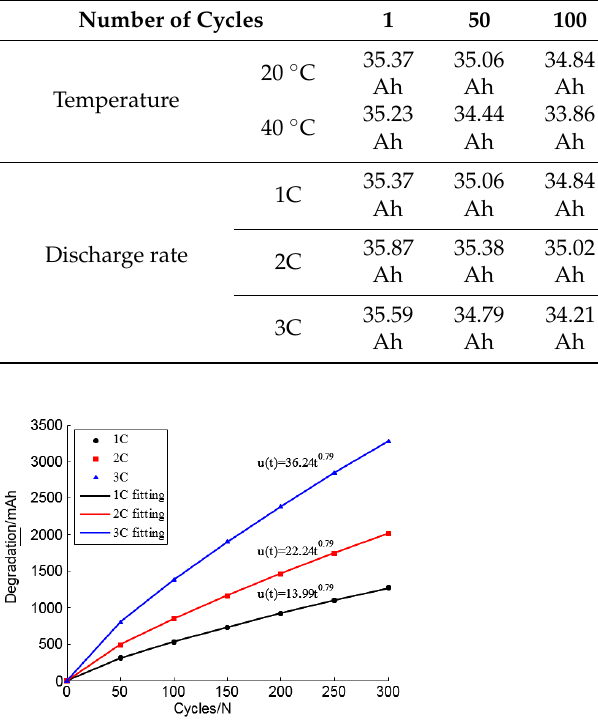
Table 1. Capacity degradation under different conditions.